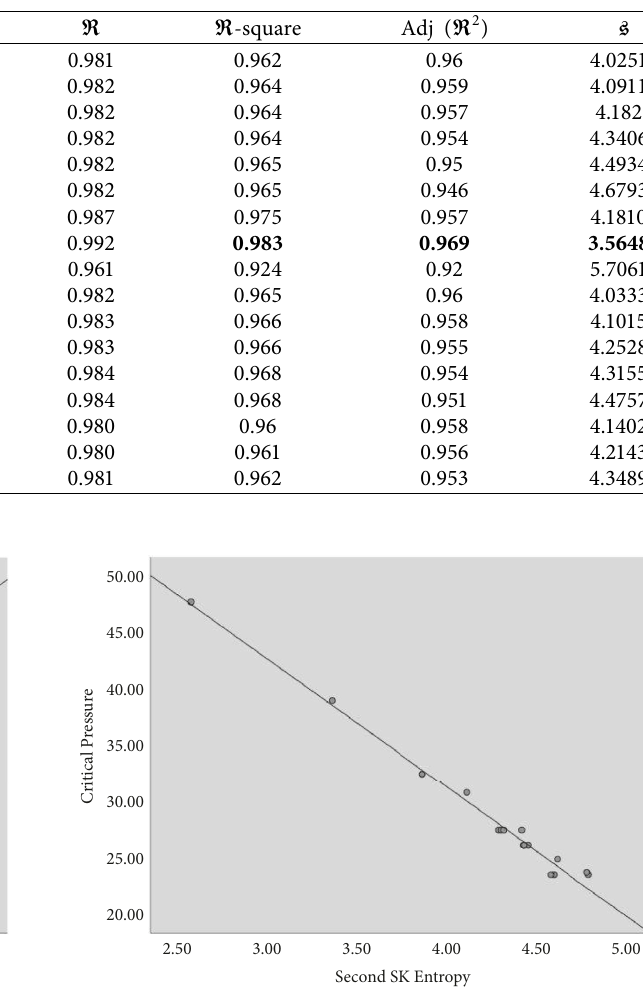
Figure 6: Graphical representation of LRM between critical pressure ( CP ) and the second SK